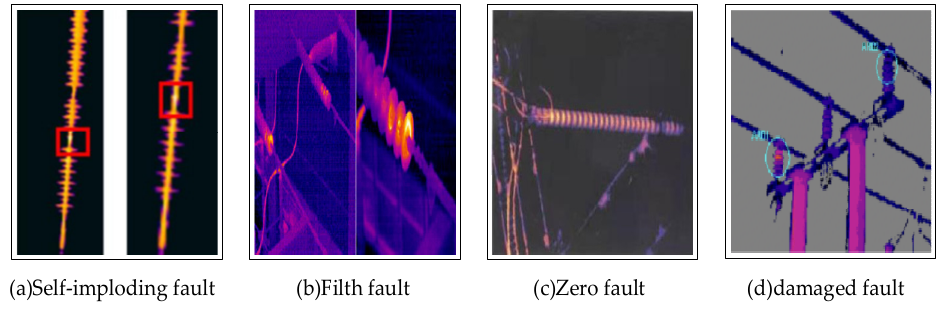
Figure 1. Four typical infrared faults.